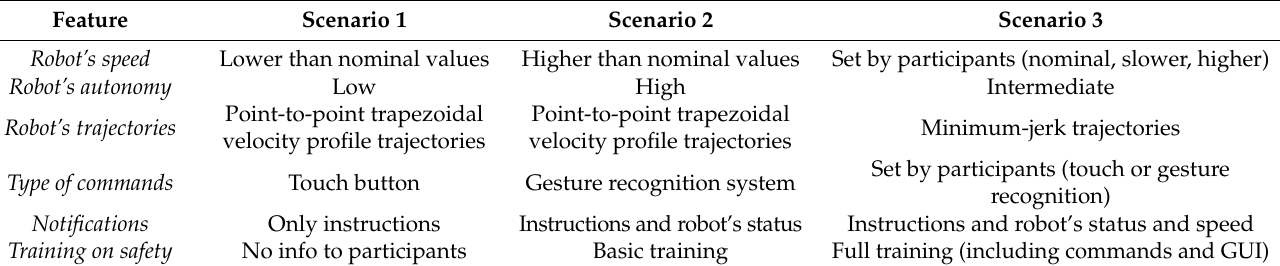
Figure 2. Participant’s point of view of the workstation.